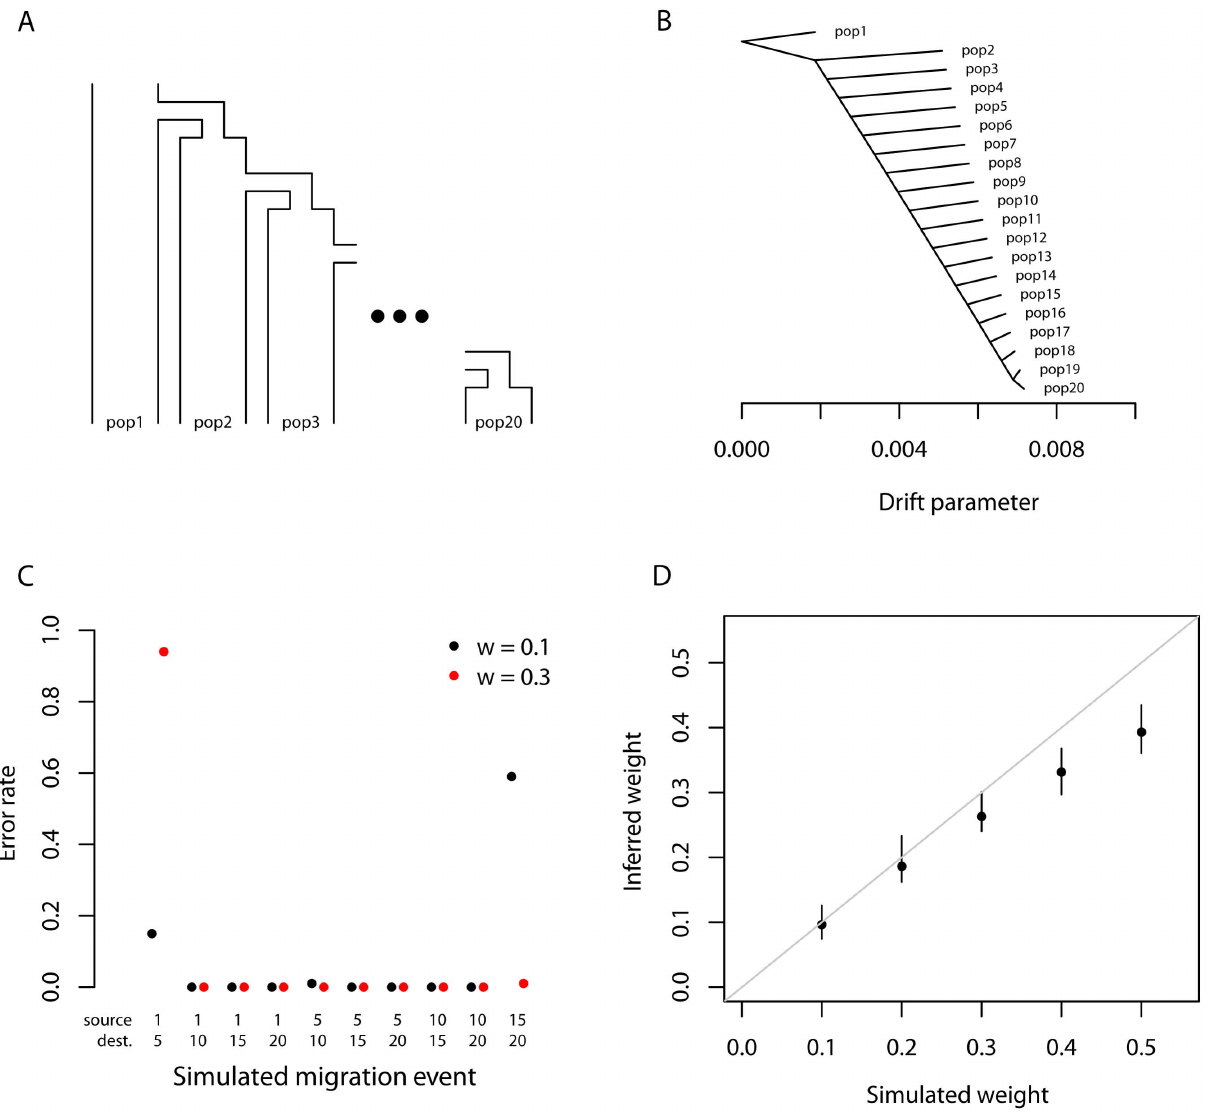
Figure 2. Performance on simulated data. A. The basic outline of the demographic model used. B. Trees inferred by TreeMix . We simulated 100 independent data sets, under the demographic model in A., and inferred the tree. All simulations gave the same topology; plotted are the mean branch lengths. C. Performance in the presence of migration. We added migration events to the tree in A. and inferred the structure of the graph. Each point represents the error rate over 100 independent simulations, defined as the fraction of simulations where the inferred graph topology does not perfectly match the simulated topology. On the x-axis we show the populations involved in the simulated migration event; e.g., if the source population is 1 and the destination population is 10, this is a migration event from population 1 to population 10, as labeled in A. D. Admixture weight estimation. We simulated admixture events with different weights from population 1 to population 10, and inferred the weight. Each point is the mean across 100 simulations, and the bar represents the